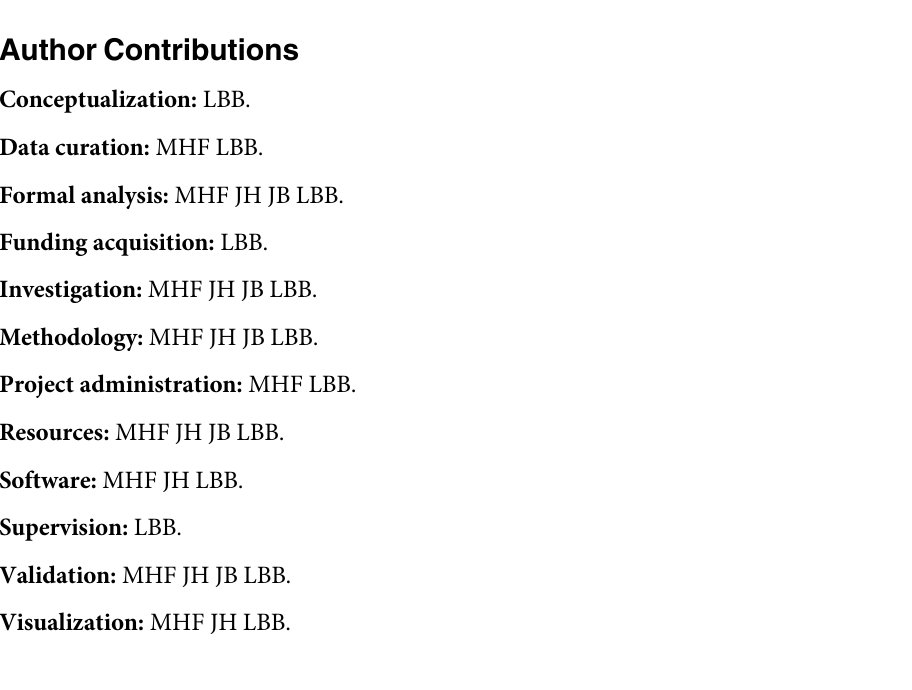
S1 Table. Raw data from the case-control